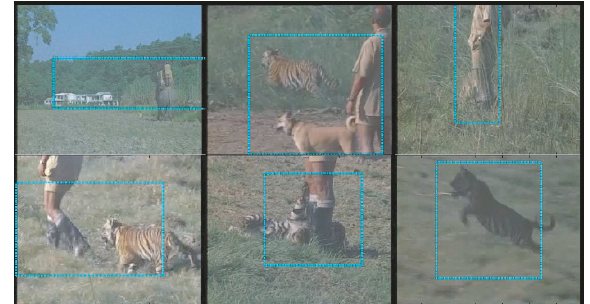
Figure 13: Examples of key-frame cropping using visual attention modelling for the optimal value of the parameter K . The rectangu-